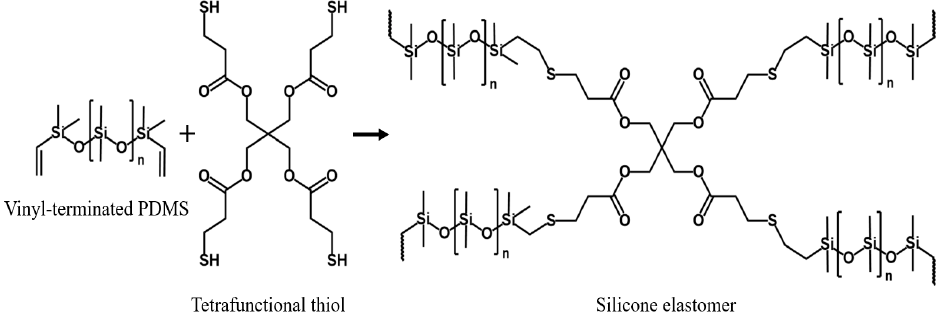
Figure 1. Chemical structure of silicone elastomeric materials used in artificial fingertips, made from vinyl-terminated PDMS(polydimethylsiloxane) and tetrafunctional thiol [47]. vinyl-terminated PDMS(polydimethylsiloxane) and tetrafunctional thiol